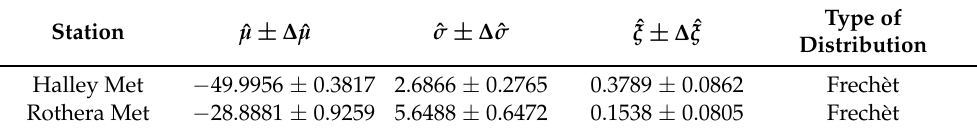
Table 3. Same information as in Table 2, but for minimum temperature